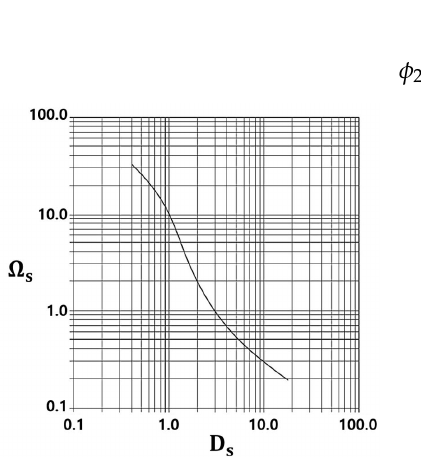
Figure 3. Cordier diagram